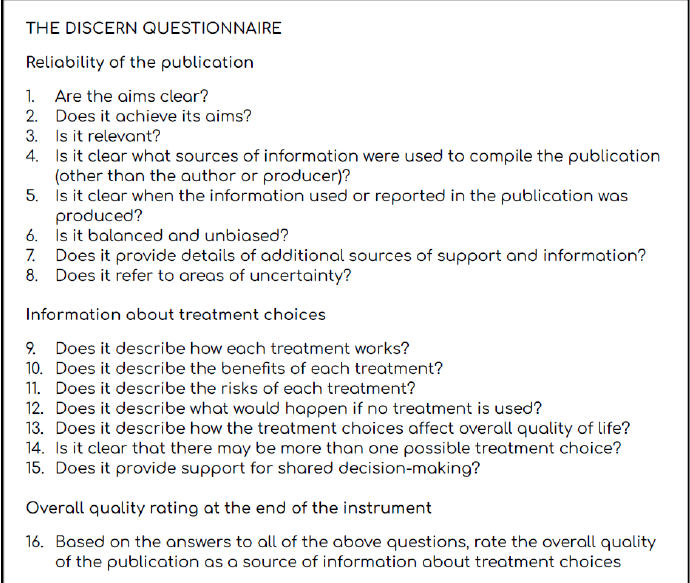
Figure 1. The DISCERN questionnaire. Graphic elaboration of the 16 questions extracted from http://www.discern.org.uk/discern_instrument.php (accessed on 3 February